Question: Which kind of chart has been used to present this data?
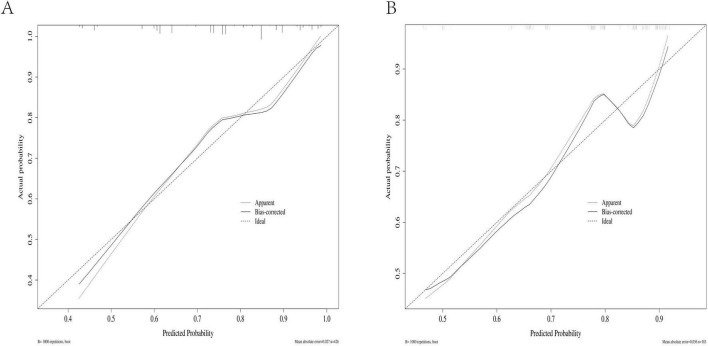
Answer: line